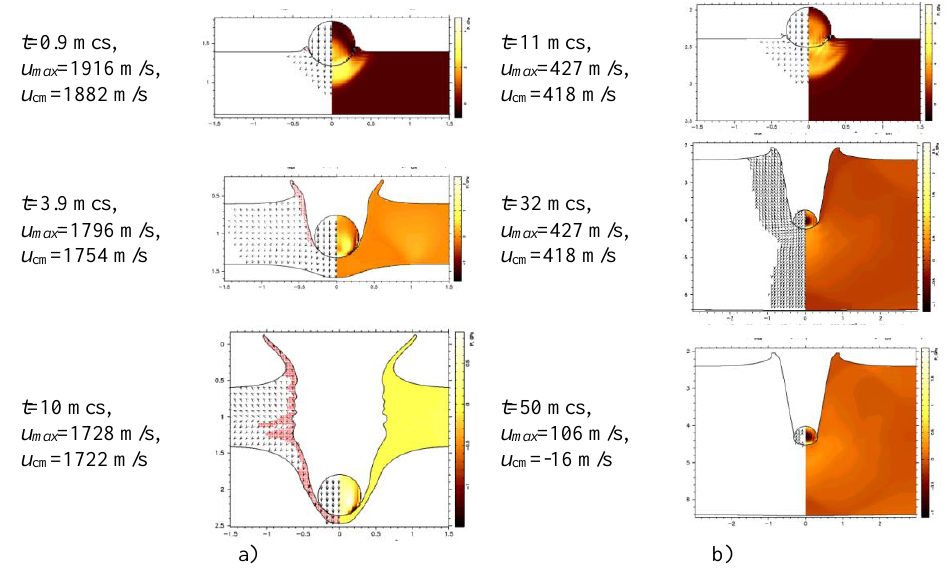
Fig 7. The chronogram of the interaction process between the drummer and the barrier made from PMMA ( a ), and with the barrier-“witness” ( b ) at V 0 = 2014 m/s The last experiment presented in fig. 8 shows the interaction of a spherical drummer with plexiglass at speed V 0 = 2441